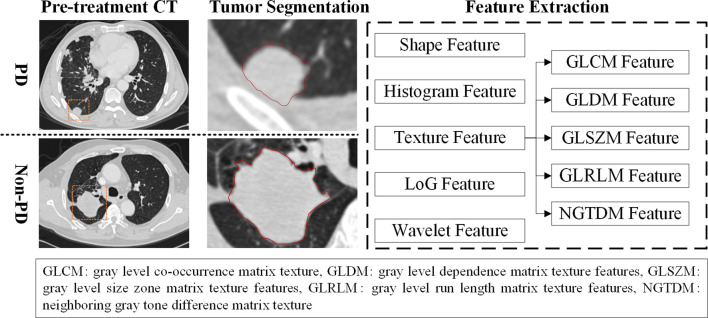
The radiomics feature extraction process.